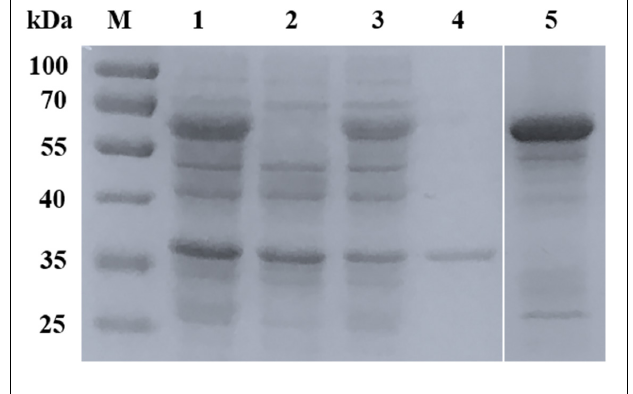
FIGURE 2 | Expression and purification of rBmSA1. SDS-PAGE analysis of the expression of rBmSA1 in E. coli BL21 (DE3). Lane M: protein marker; Lane 1: lysate of induced bacterial cells transformed with pGEX-6p-1-BmSA1; Lane 2: lysate of un-induced bacterial cells transformed with pGEX-6p-1-BmSA1; Lane 3: supernatant from lysate of bacterial cells induced by IPTG; Lane 4: pellets from lysate of bacterial cells induced by IPTG; Lane 5: purified rBmSA1 after dialysis and concentration.